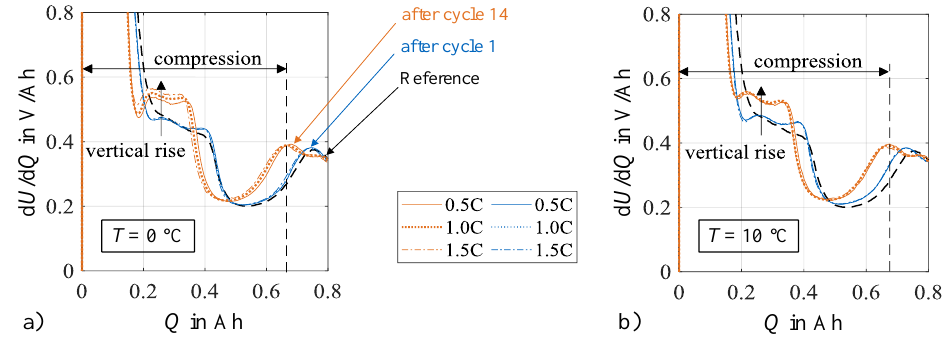
Figure 12. Compression between charging start and graphite peak as well as formation and increase of silicon characteristics due to increasing number of cycles at ( a ) 0 °C and ( b ) 10 °C.